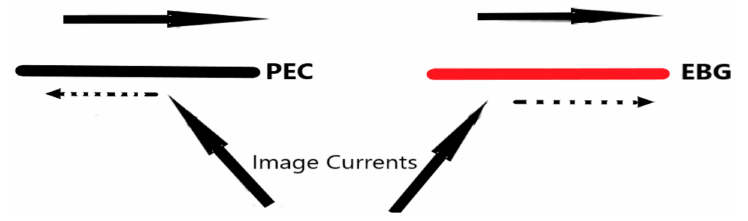
Figure 2. Wire antenna with PEC, adapted from